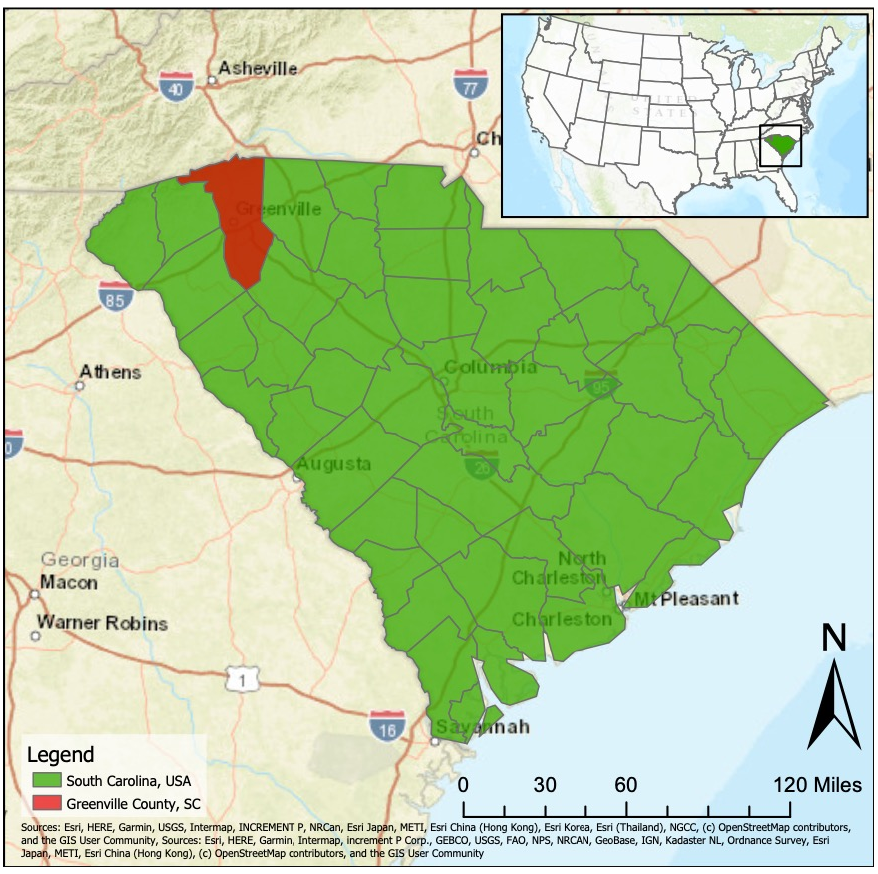
Figure 1. Greenville County, SC, USA.